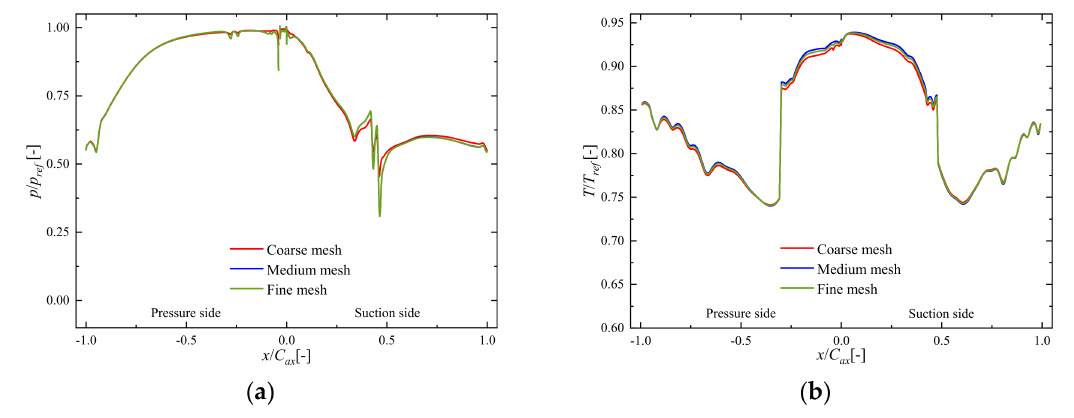
Figure 2. Grid independence test. ( a ) Pressure profile; ( b ) Temperature profile.